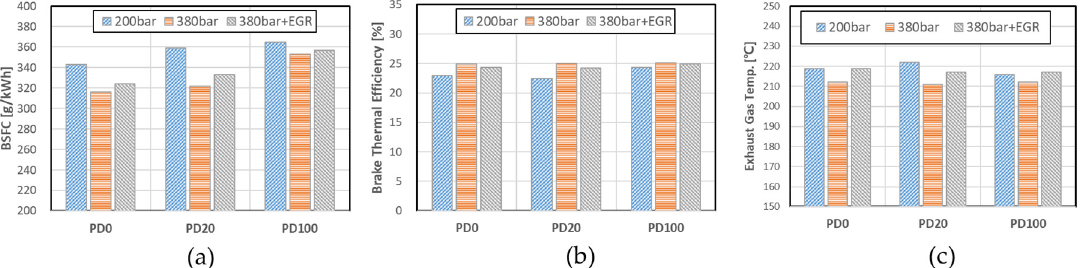
Figure 10. Thermal Efficiency and fuel consumption. ( a ) brake specific fuel consumption (BSFC), ( b ) brake thermal efficiency (BTE), and ( c ) exhaust gas temperature.